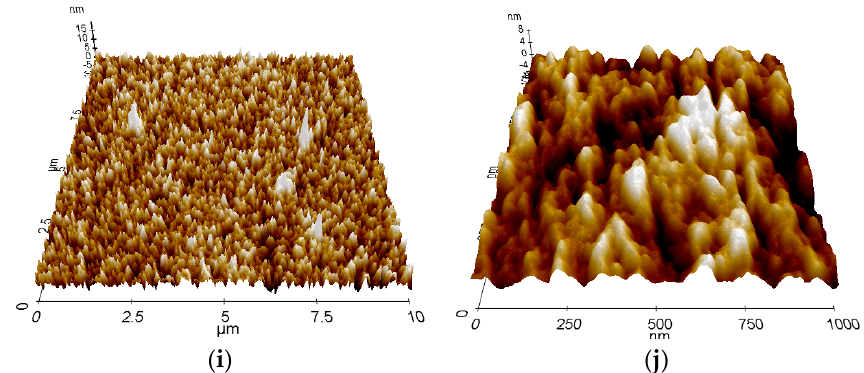
Figure 7. AFM 10 × 10 μ m and 1 × 1 μ m 3D topographic images of surface of PDPP4T ( a , b ), PDBPyBT ( c , d ) and their blends—PDPP4T (50%):PDBPyBT (50%) ( e , f ), PDPP4T (75%):PDBPyBT (25%) ( g , h ), PDPP4T (25%):PDBPyBT (75%) ( i , j ).